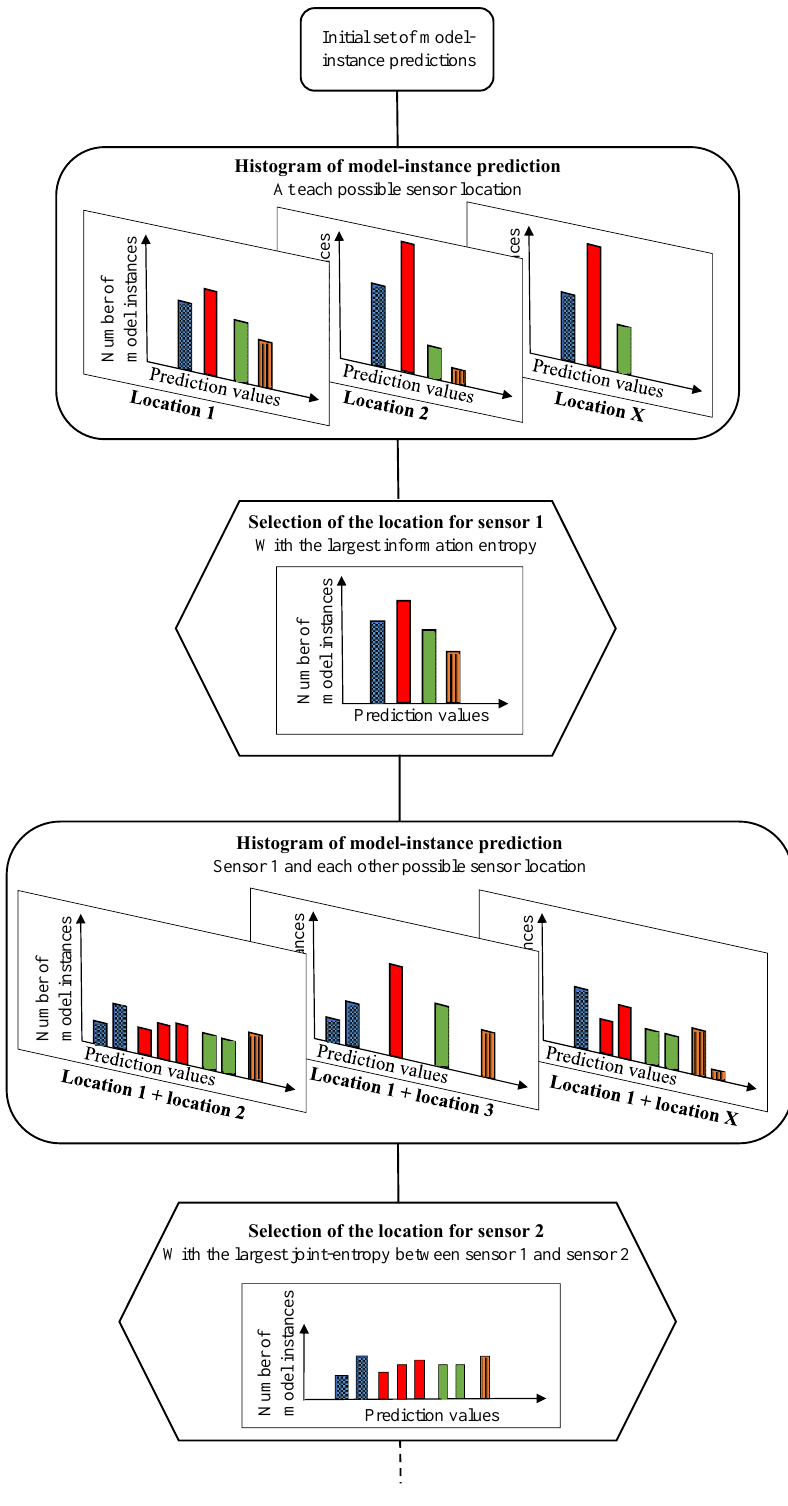
Figure 3. Schematic of the hierarchical algorithm for sensor placement where histograms at possible sensor locations are composed of subset of model instances depicted in distinctive bars.